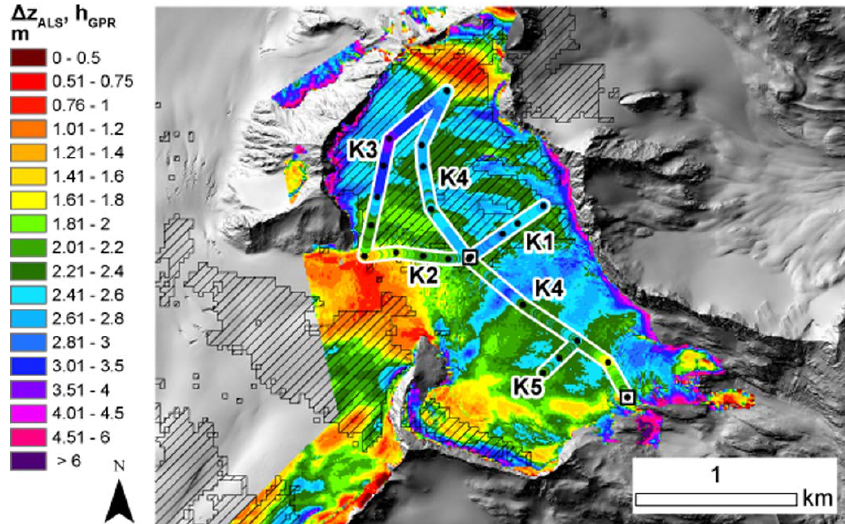
Fig. 9. Spatial distribution of ALS-derived surface elevation changes from 4 October 2011 to 11 May 2012. Snow depths calculated from GPR measurements along the profiles at Kesselwandferner shown in the same colour-scale. Black dots indicate locations of snow depth probing. Locations of snow pits are shown as white squares. Snow covered areas derived from Landsat image of 31 August 2009 (LSC) are